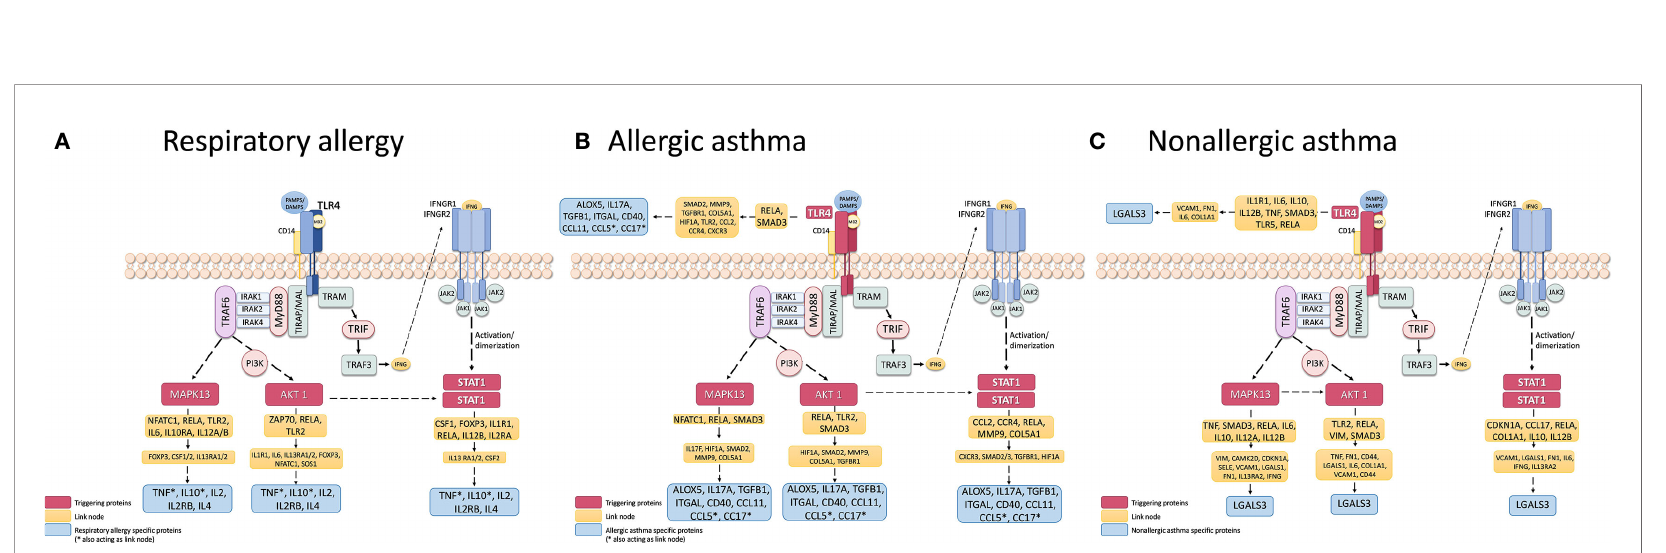
FIGURE 5 | Schematic representation of the triggering protein-activation pathway for each disease, using as a target the protein de fi ned as highly speci fi c for these diseases. The proteins that link these pathways with proteins with high mechanistic value for this speci fi c disease are indicated in yellow. Supplementary Figure 2 represents the pathway scheme obtained by Pathlinker analysis using the the Cytoscape V3.6.1 (https://cytoscape.org/) program. (A) Respiratory Allergy. (B) Allergic Asthma. (C) Non-allergic Asthma.